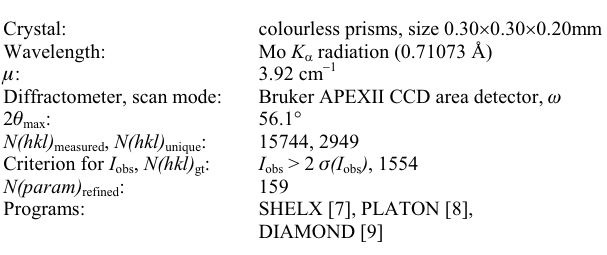
Table 1. Data collection and handling.